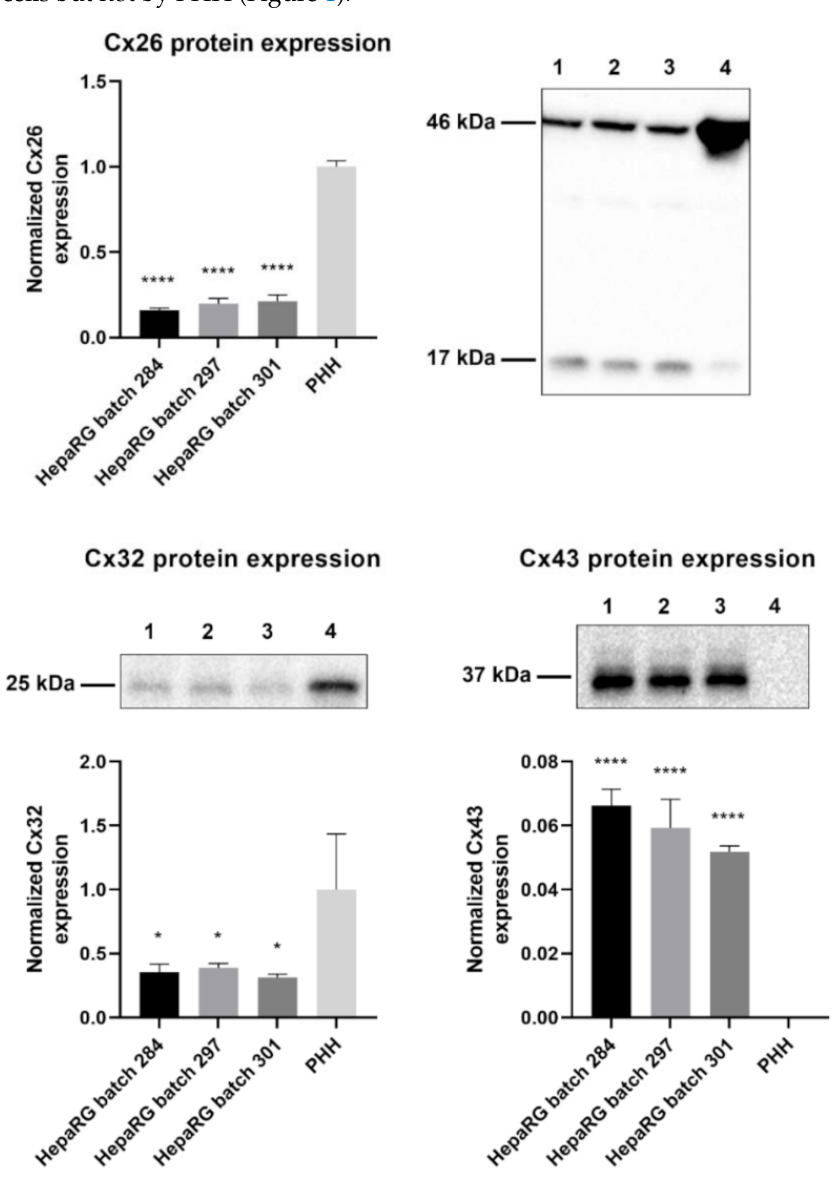
Figure 1. Cx26, Cx32, and Cx43 protein expression in human hepatoma HepaRG cells compared to primary human hepatocytes (PHH). Proteins were extracted from human hepatoma HepaRG cells ( n = 3 and N = 3) and PHH ( n = 1 and N = 3) and immunoblotting was performed. Densiometric quantitative data were obtained via Image Lab 6.0.1 software (Bio-Rad, Hercules, CA, USA). Data were normalized to the total protein loading (Figure S1) and expressed as a ratio to PHH (if the target was expressed in PHH). Significant differences compared to PHH were calculated with a parametric one-way analysis of variance (ANOVA) followed by a Dunnett’s post-hoc test to correct for multiple comparisons. Data are expressed as mean ± standard deviation with * p ≤ 0.05 and **** p ≤ 0.0001. (1 = HepaRG batch 284; 2 = HepaRG batch 297; 3 = HepaRG batch 301; 4 =